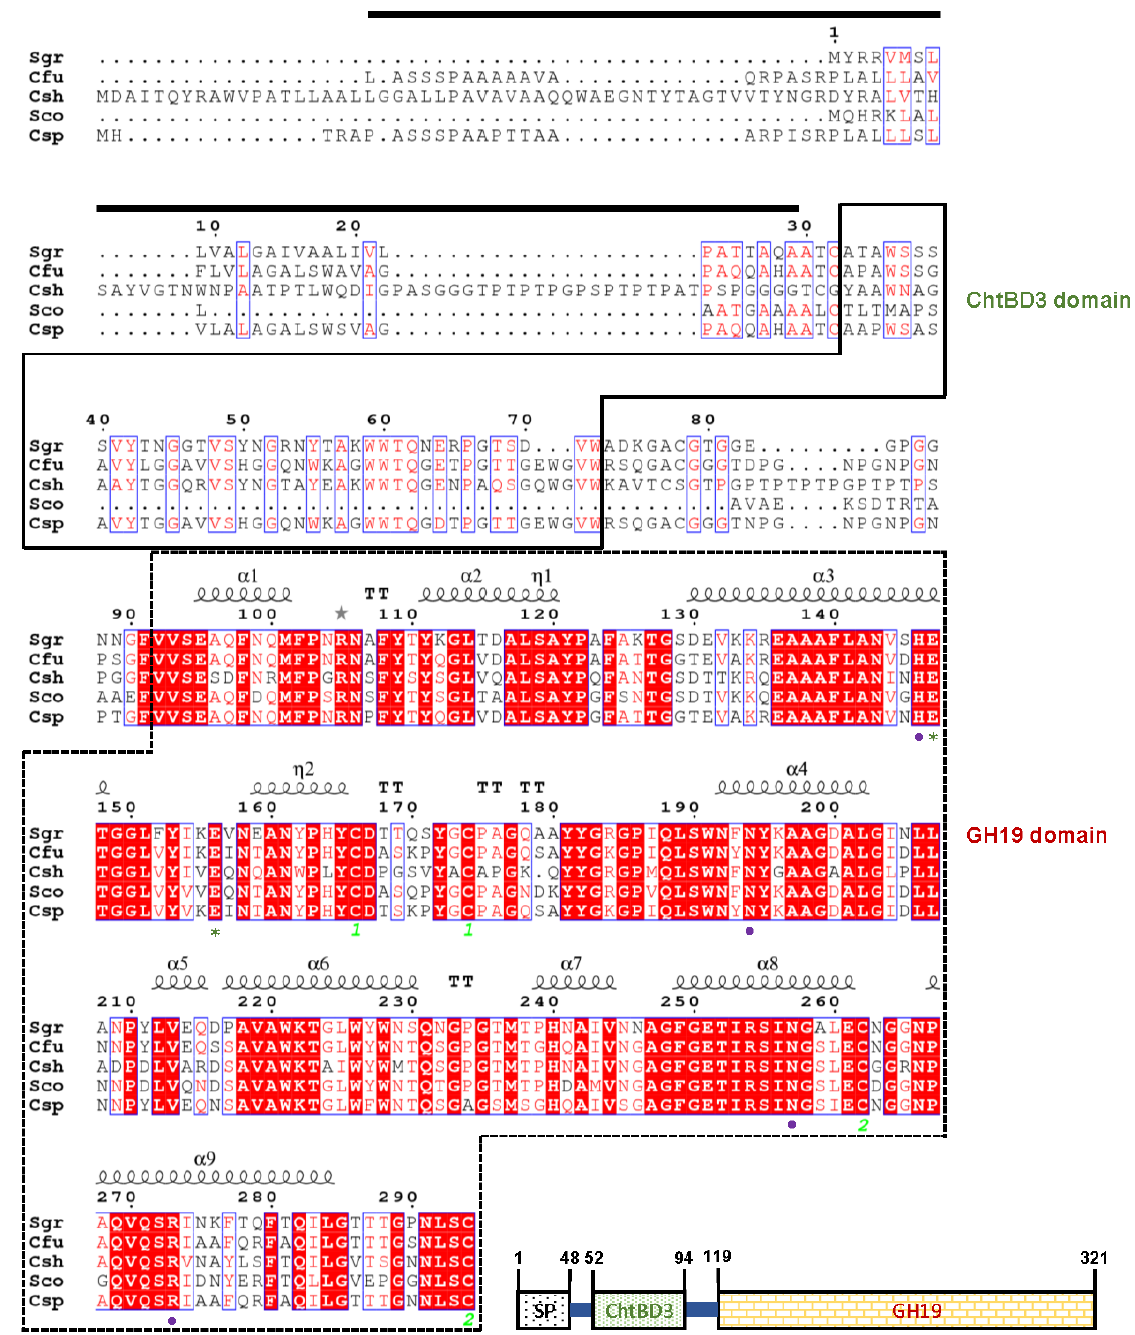
Figure 1. Domain architecture of Cellulosimicrobium funkei HY-13 GH19 chitinase (ChiJ) and structure-based sequence alignment of the enzyme and its structural homologs, which was generated using ESPript 3.0 server (https://espript.ibcp.fr/ESPript/ESPript, accessed on 12 May 2021). The first line shows the secondary structure elements ( α -helix, squiggle; 3 10 -helix, η ; β -turn, TT) of Streptomyces griseus HUT6037 GH19 chitinase (PDB code: 1WVU) employed as a template. Sequences (GenBank accession numbers): Sgr: Streptomyces griseus HUT6037 GH19 chitinase (BAA23739); Cfu: C. funkei HY-